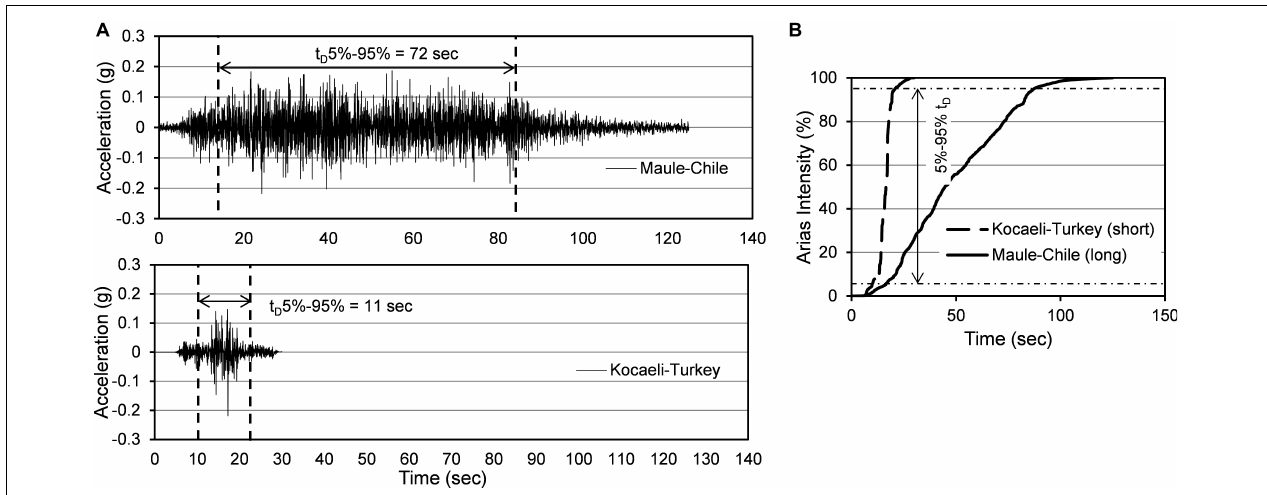
FIGURE 1 | (A) Acceleration time history and (B) Arias Intensity of a long duration and short duration motion having similar PGA.